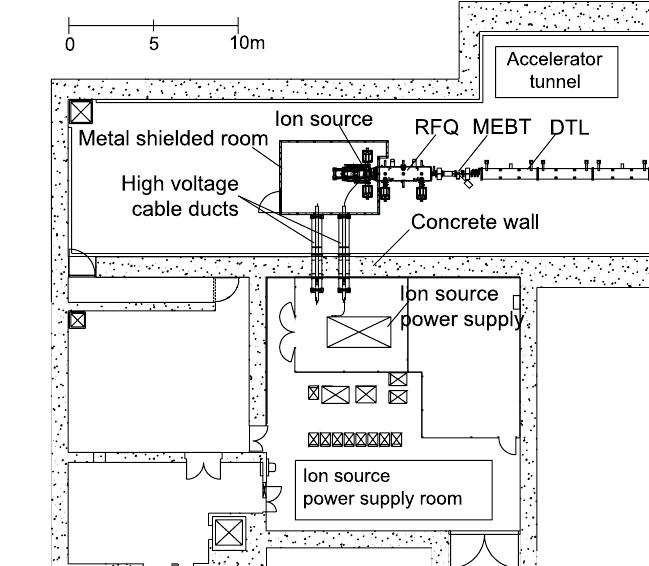
system.FIG. FIG. 10. Layout of J-PARC ion source